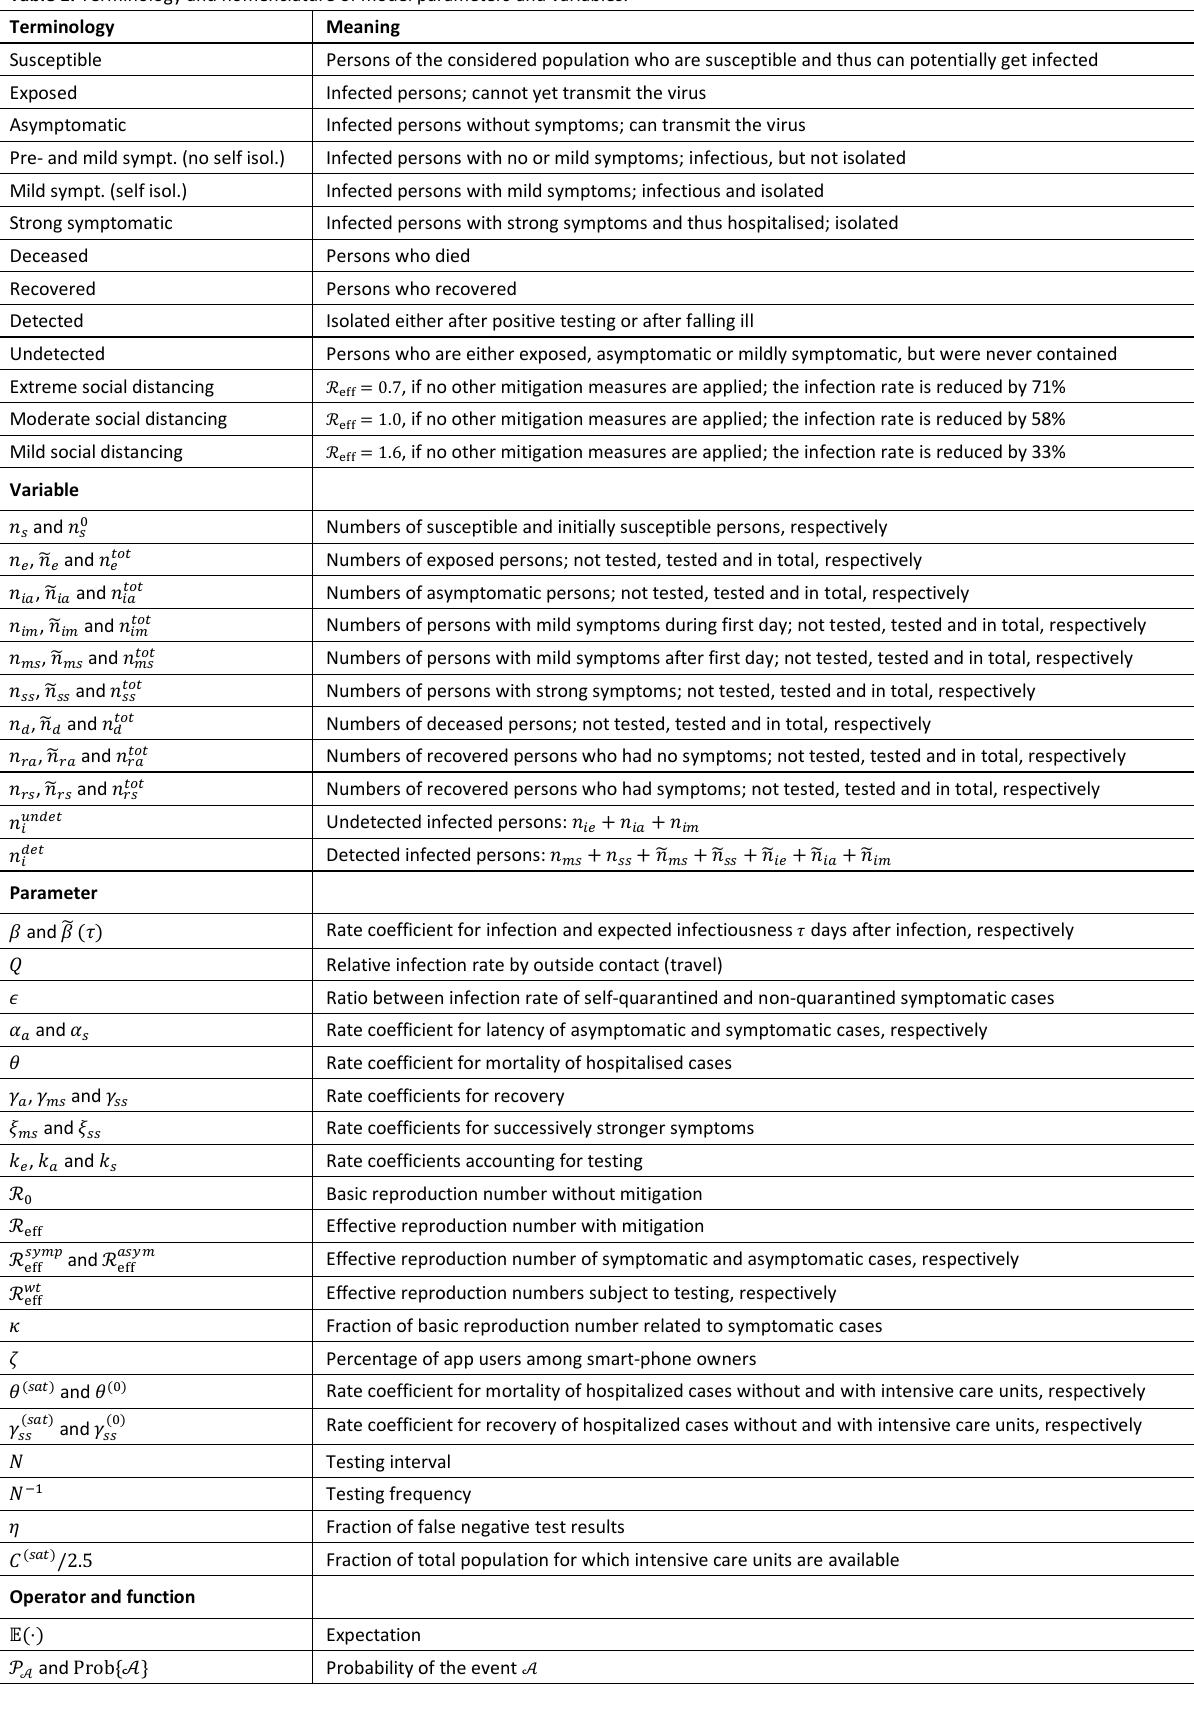
Table 1: Terminology and nomenclature of model parameters and variables.